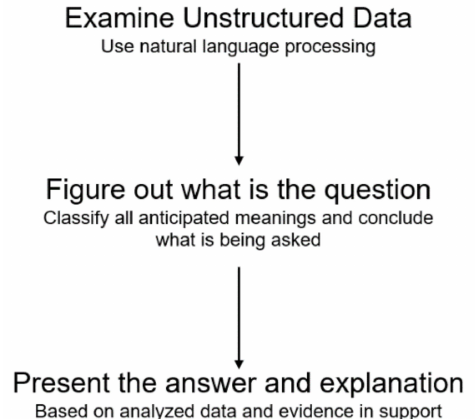
Figure 8. Step of how IBM Watson finds critical